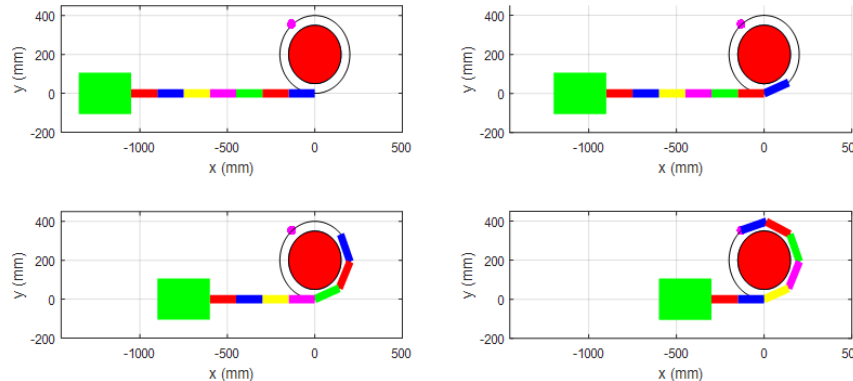
Figure 11. Planar path tracking of the CDSLM.